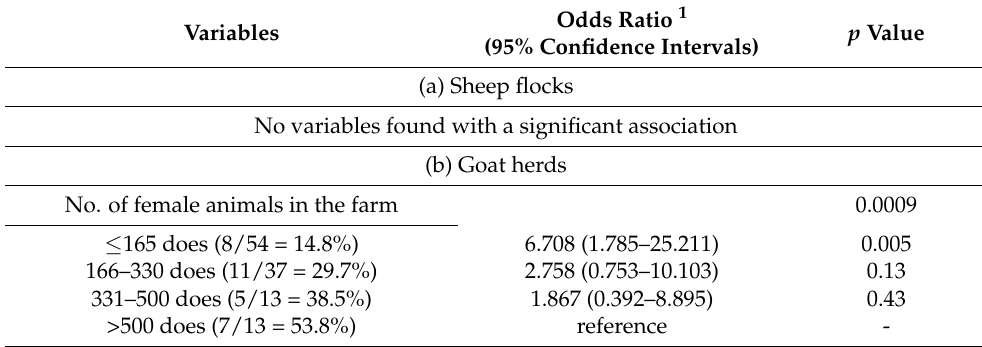
Table A6. Multivariable analysis for variables associated with optional vaccination against paratu- berculosis in 444 small ruminant farms in